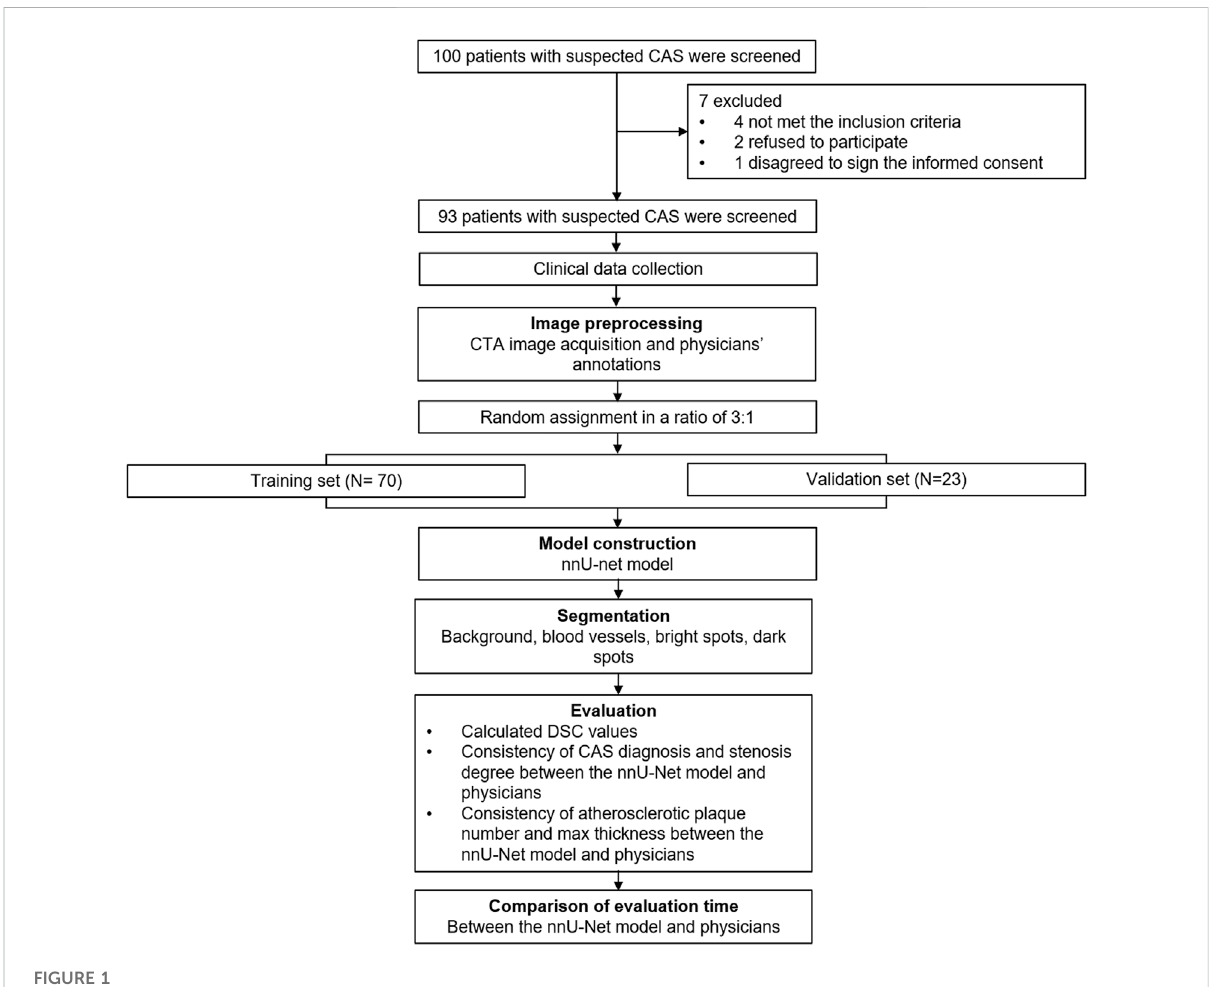
FIGURE 1 Study fl